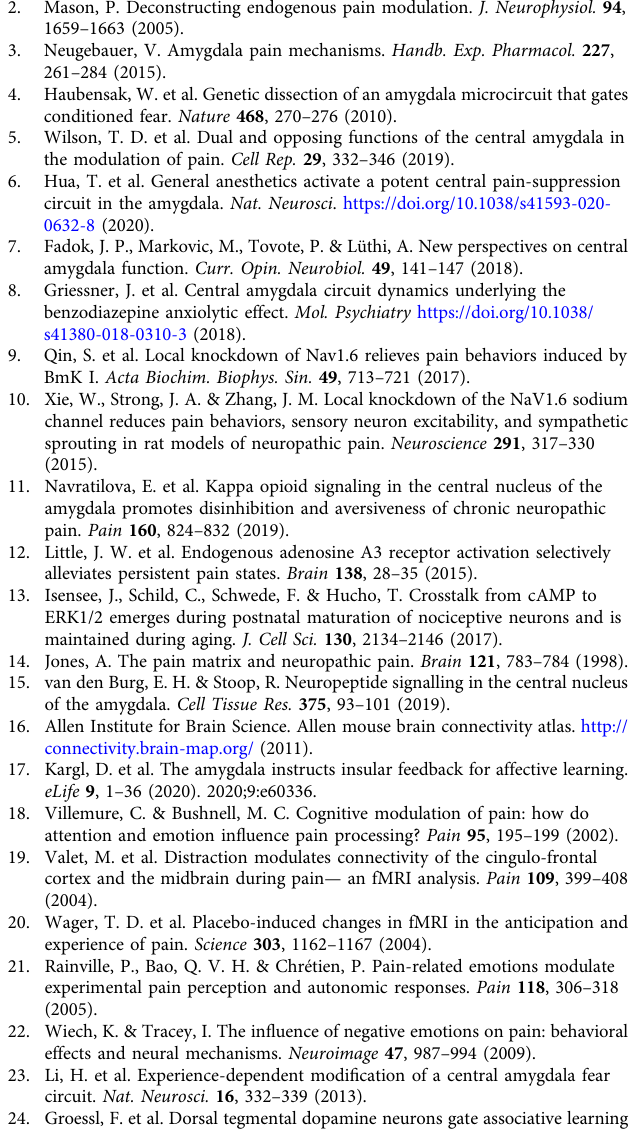
GSE95154. Supplementary Fig. 3: raw histological data are available upon request; Supplementary Figs. 4, 5, and 7: raw fMRI data are available upon request; Supplementary Fig. 6: raw behavioral data is available upon